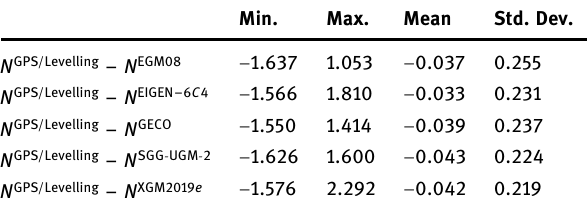
Table 3: Statistics of the di ff erences between geoids undulations derived from di ff erent GGMs - HR and GPS/levelling - derived geoid heights in meters Min. Max. Std.